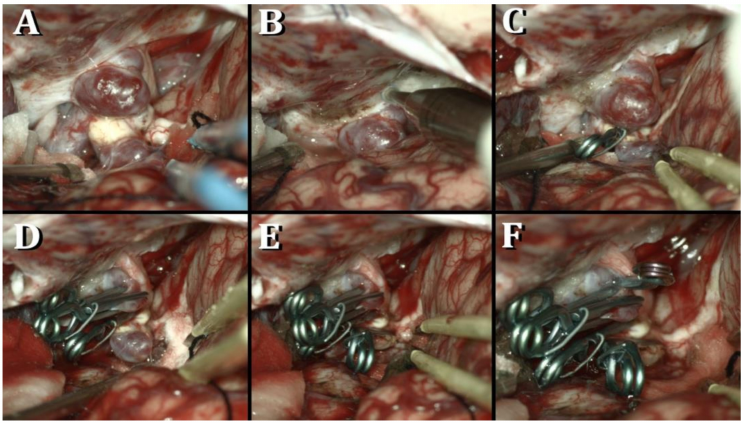
Figure 2. ( A ) Aneurysm’s exposure; ( B ) anterior clinoidectomy; ( C – F ) clipping of the tandem paraclinoid internal carotid artery